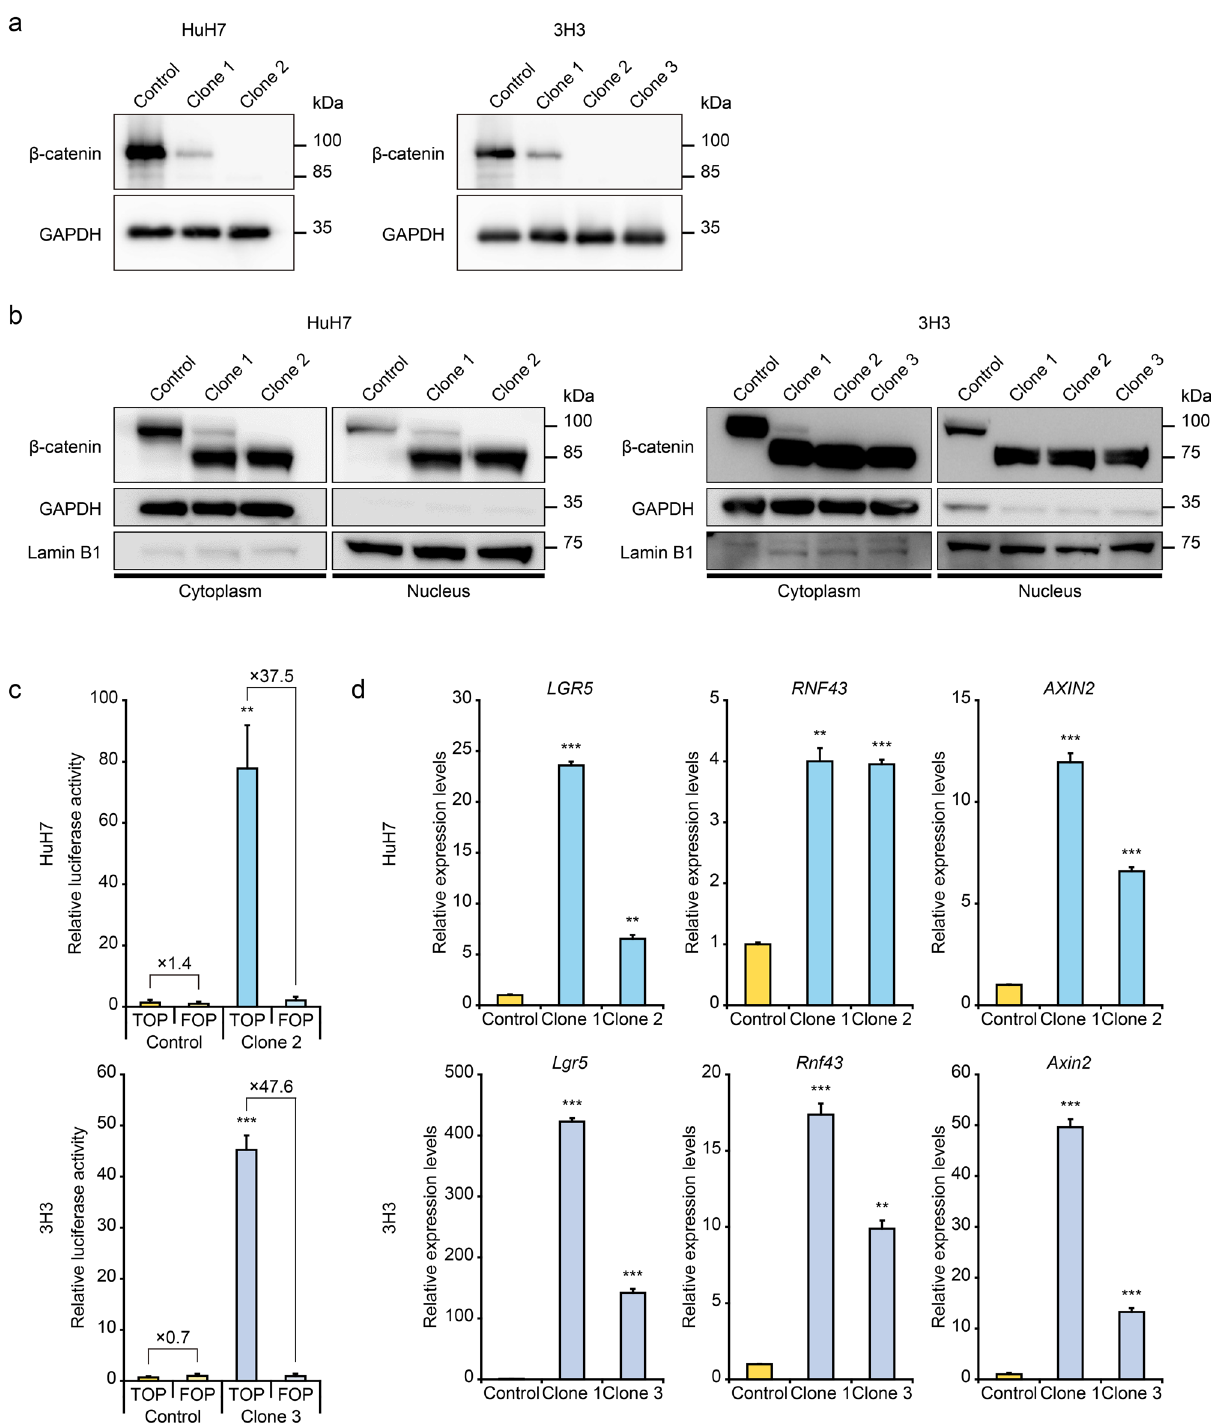
Figure 2. Activation of the Wnt/β-catenin signaling pathway in HCC cells harboring exon 3 skipping β-catenin. ( a ) Immunoblot analysis of β-catenin by using an antibody targeting amino acids 29–49 of β-catenin. Full- length blots are presented in Supplementary Figure X. ( b ) Immunoblot analysis of cytoplasmic and nuclear protein fractions. GAPDH and lamin B1 were used as controls of the cytoplasmic and nuclear protein fractions, respectively. Full-length blots are presented in Supplementary Figure X. ( c ) TOPFlash dual luciferase assay. Luciferase activity of control cells transfected with the FOPFlash vector was used as a control. ( d ) Quantitative RT-PCR analysis of downstream genes of the Wnt/β-catenin signaling pathway. Error bars are the mean ± SD. P -values were calculated by Welch’s t test. ** P < 0.01; *** P <